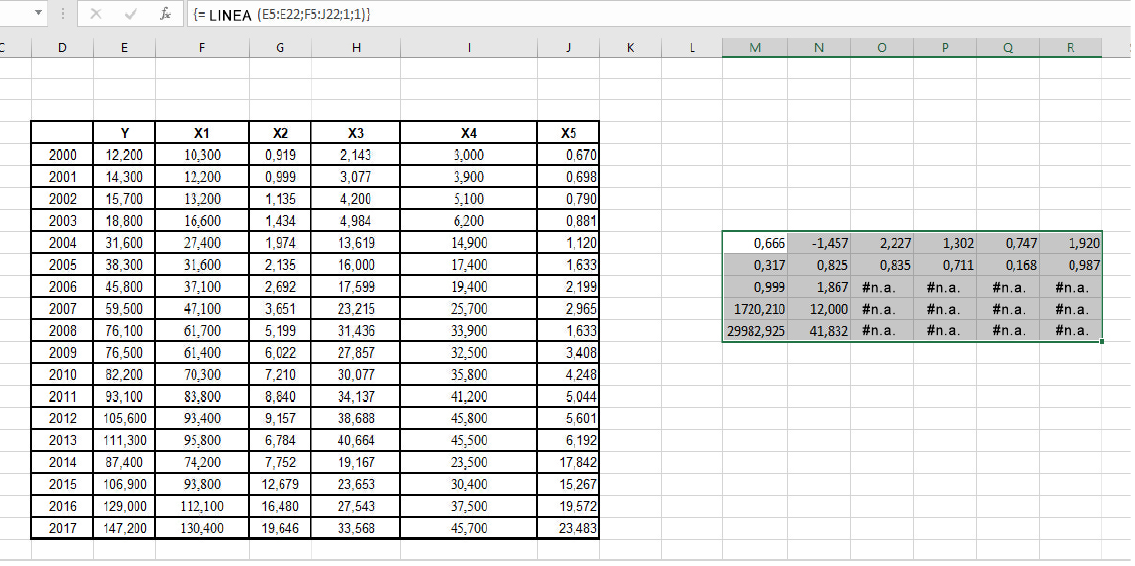
Figure 2. Parameters calculation for the interaction between the resulting indicator functional and the independent model